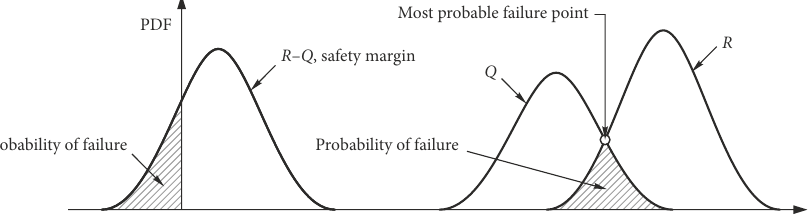
Figure 1. PDFs of Q and R and the probability of failure (adapted from Nowak & Collins,